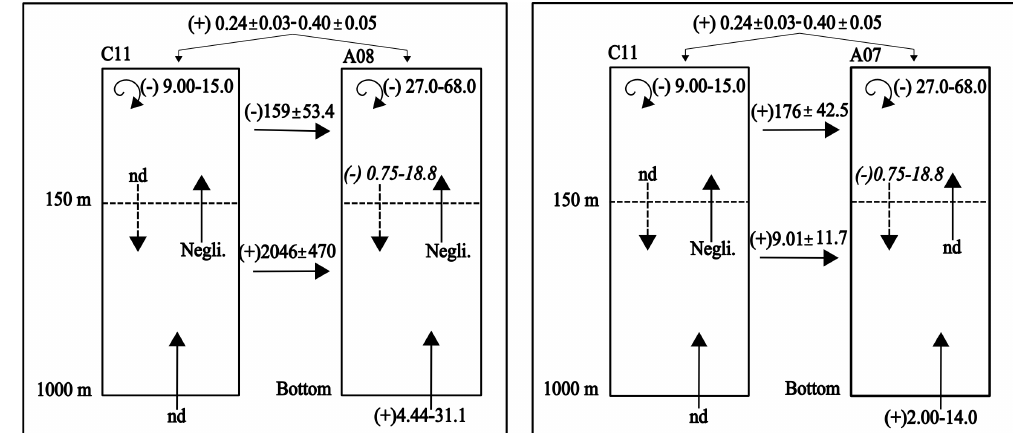
Fig. 5. Budget of DCo and PCo on the eastern slope of the Kerguelen Plateau. All fluxes are in nmolCom − 2 d − 1 and estimated for an assumed steady state. All estimates are derived as described in Fig. 3, except the lateral advective fluxes of DCo and PCo (5), which were estimated from cobalt concentrations gradients between C11 and A07 and between C11 and A08 in the 0–150m depth upper water layer and in the deep water layer between 400 and 1000m depth, with a mean current velocity of 0.08ms − 1 (Park et al., 2008a). As there are no PCo data available at A07 and A08, the downward PCo export flux (2) was estimated using PCo measured at B05 (closest station with available PCo data). Note: “nd” means not determined; “Negli.” means negligible